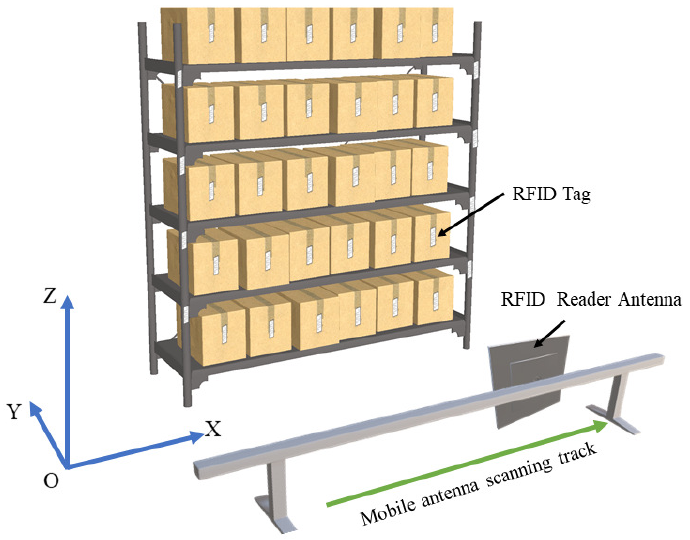
Figure 1. Conceptual diagram of